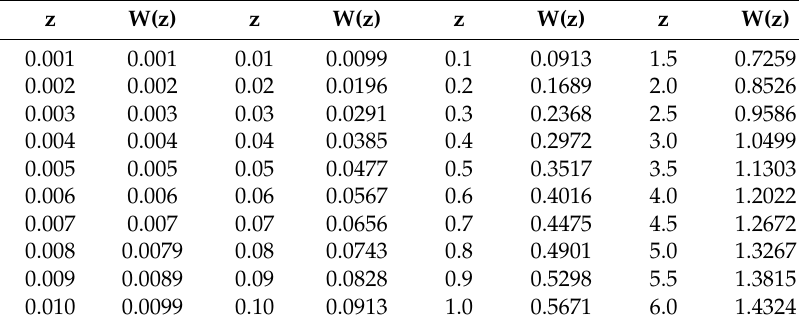
Table 1. Values of Lambert W function.